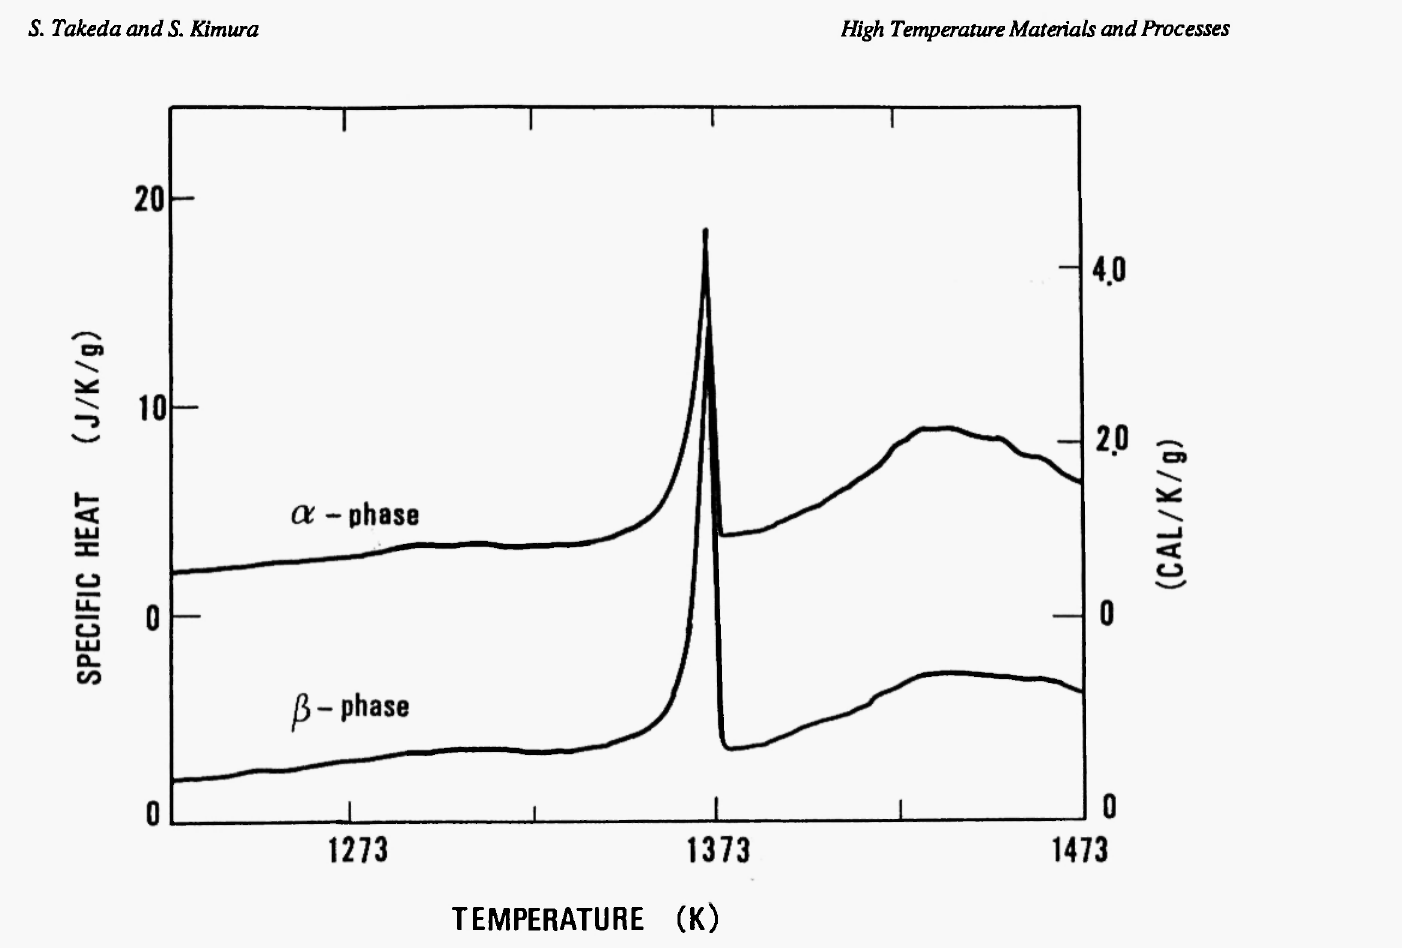
TEMPERATURE Fig. 5: Temperature dependence of specific heat for a- and